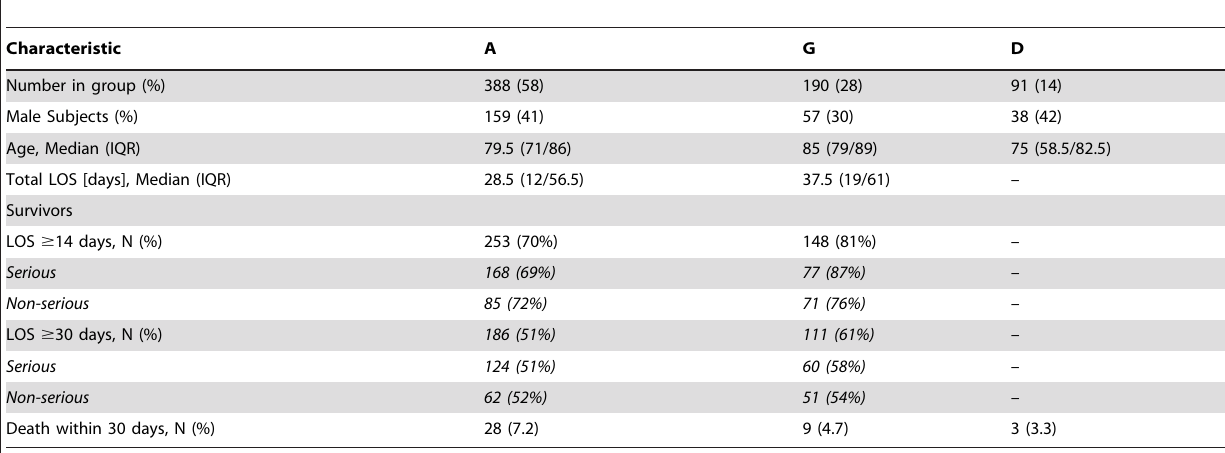
Table 2. Characteristics of the BANC study population, shown for admitted, transferred to geriatric hospital and discharged